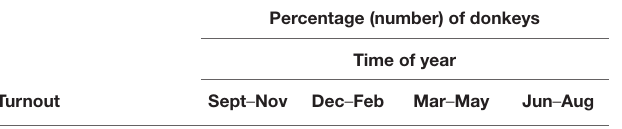
TABLE 7 | Dietary management provided for donkeys across smallholder farms in Western Liaoning and Eastern Inner Mongolia of China ( n = 1,658). Feed type and feeding